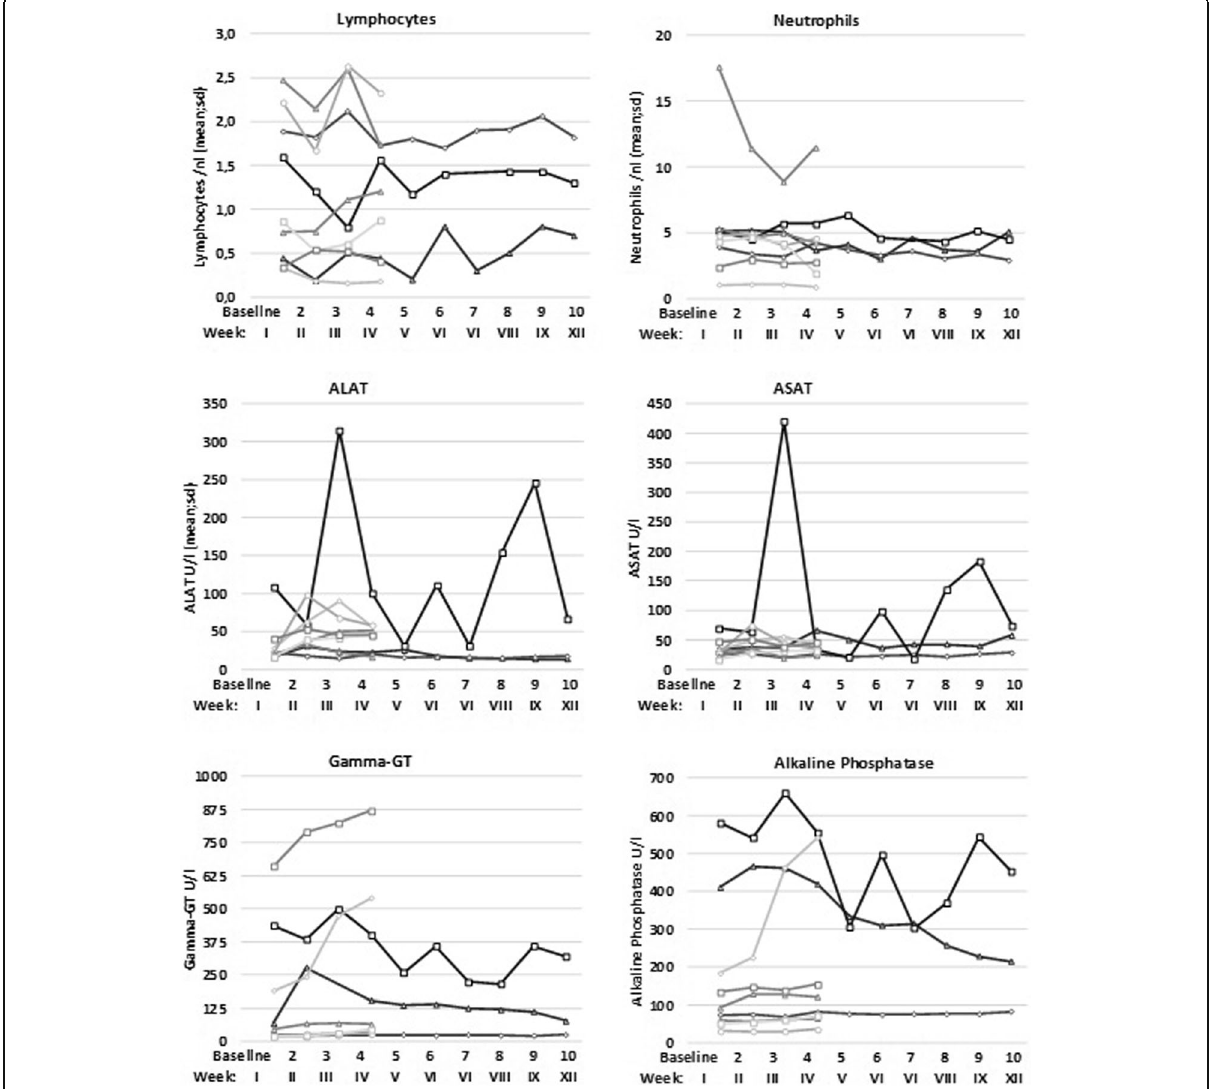
Fig. 1 Course of selected laboratory parameters (neutrophils, lymphocytes, alanine aminotransferase, aspartate aminotransferase, alkaline phosphatase, gamma-glutamyltransferase) of all nine patients (6 treated for 3 weeks, 3 treated for 9 weeks) in the 2.000 mg dose-group. Arabic figures indicate the number of visit